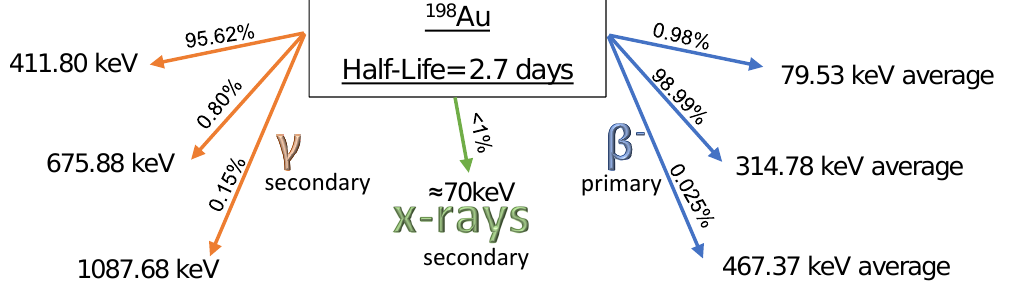
Figure 1. Gold-198 decay scheme.